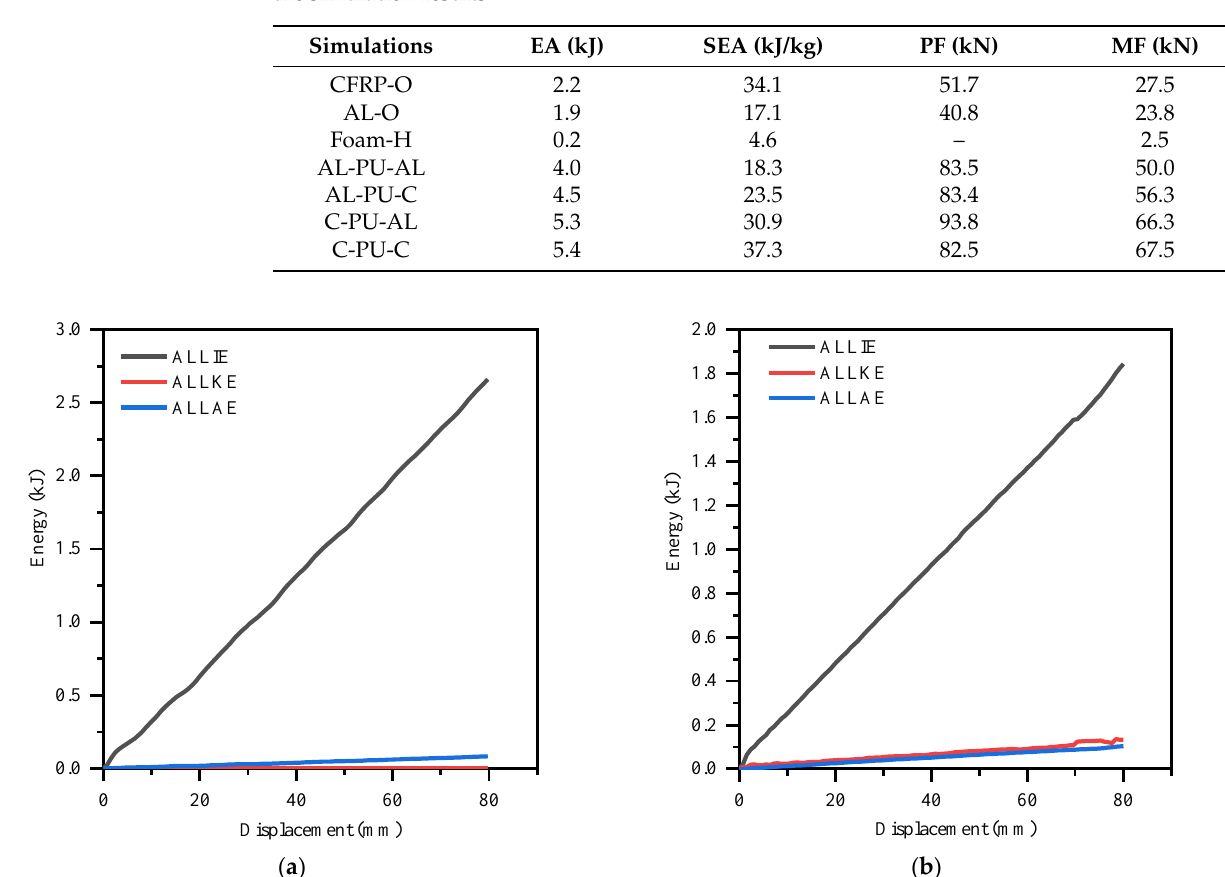
Figure 11. Comparison of energy–displacement curves between artificial strain energy (ALLAE), internal energy (ALLIE) and kinetic energy (ALLKE) of the simulation results: ( a ) AL-PU-AL; ( b ) C-PU-C.